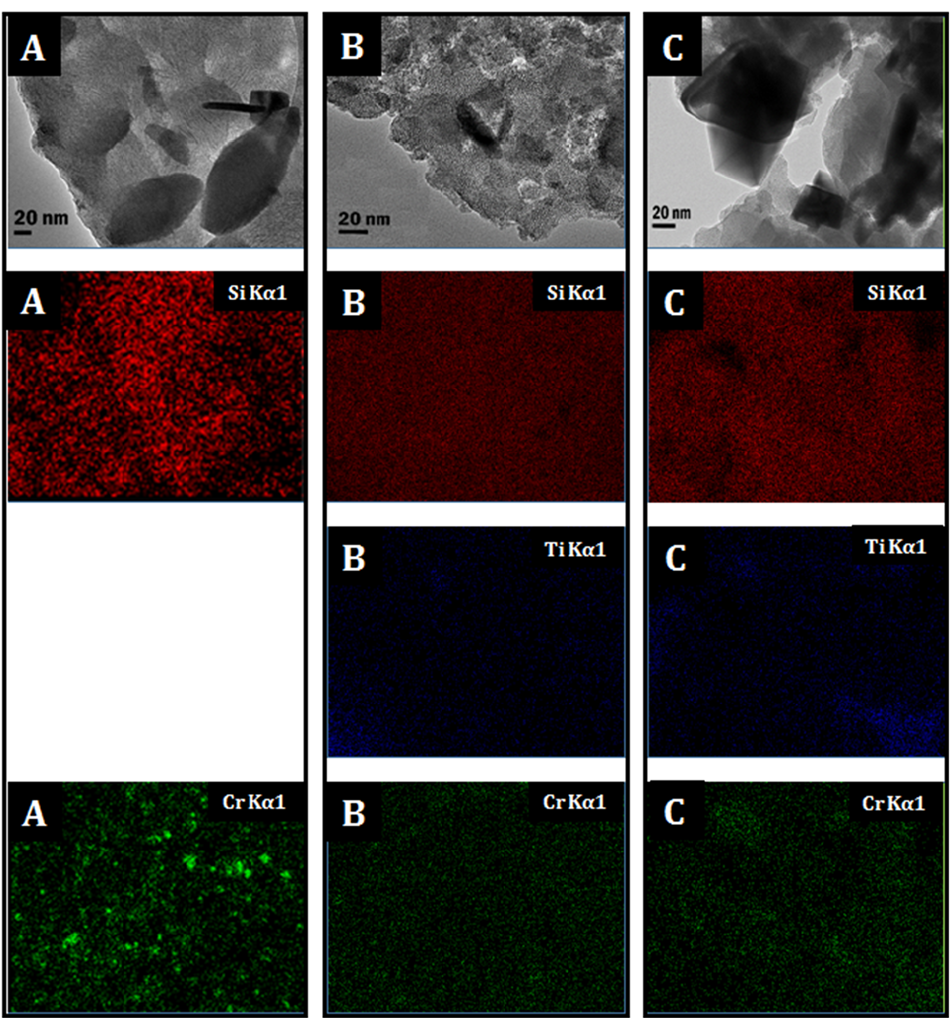
Figure 1. TEM images and EDX elemental mapping of ( A ) Cr(8)/MCM41, ( B ) Cr(8)/Ti(2.2)–Si and ( C ) Cr(8)/Ti(9.2)–Si catalysts. Crystals 2020 , 10 , x FOR PEER REVIEW